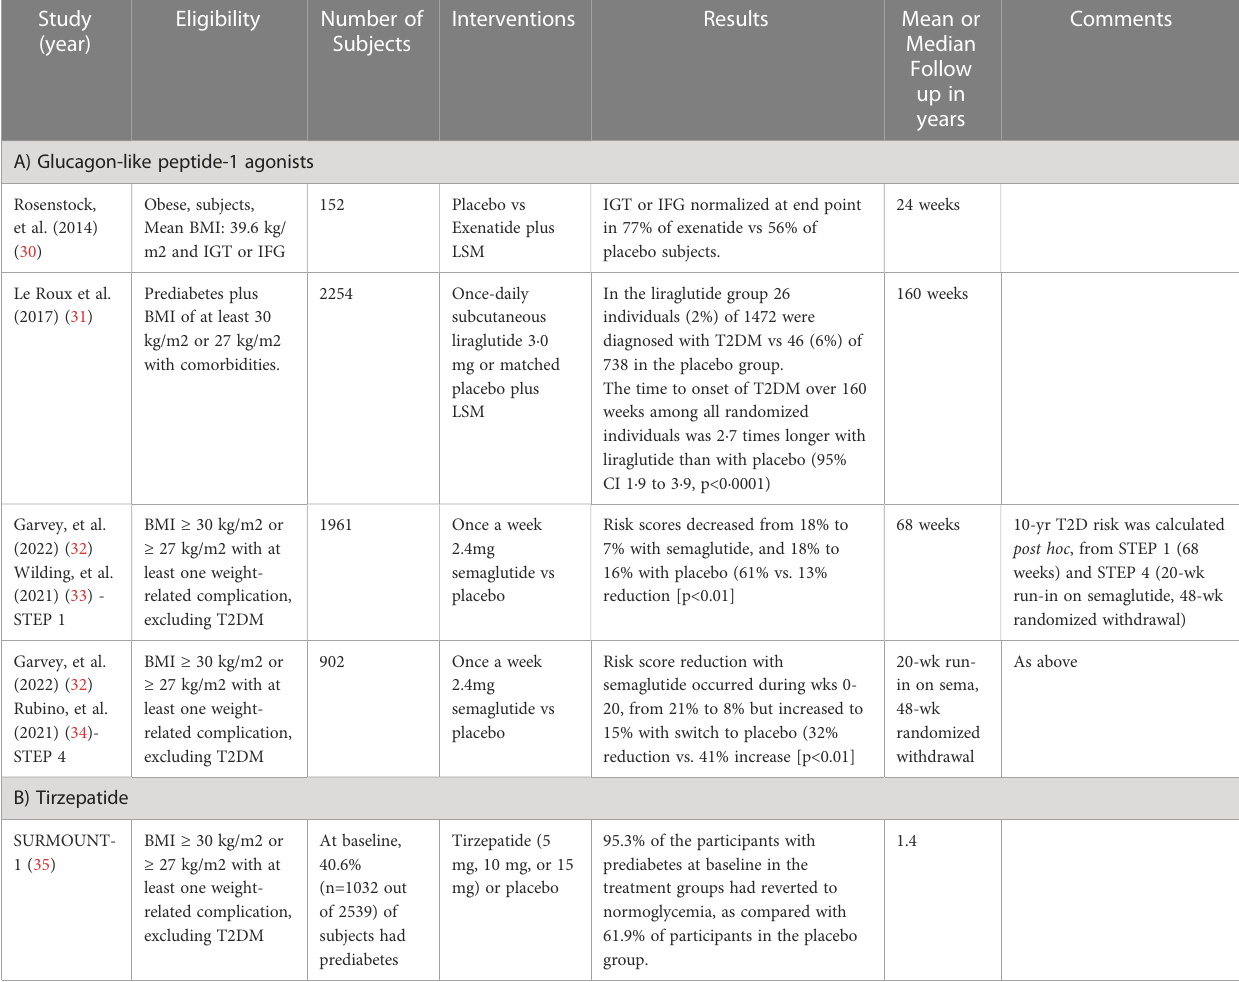
TABLE 2 Summary of evidence on T2DM prevention with medications promoting both glucose-lowering and weight-loss.